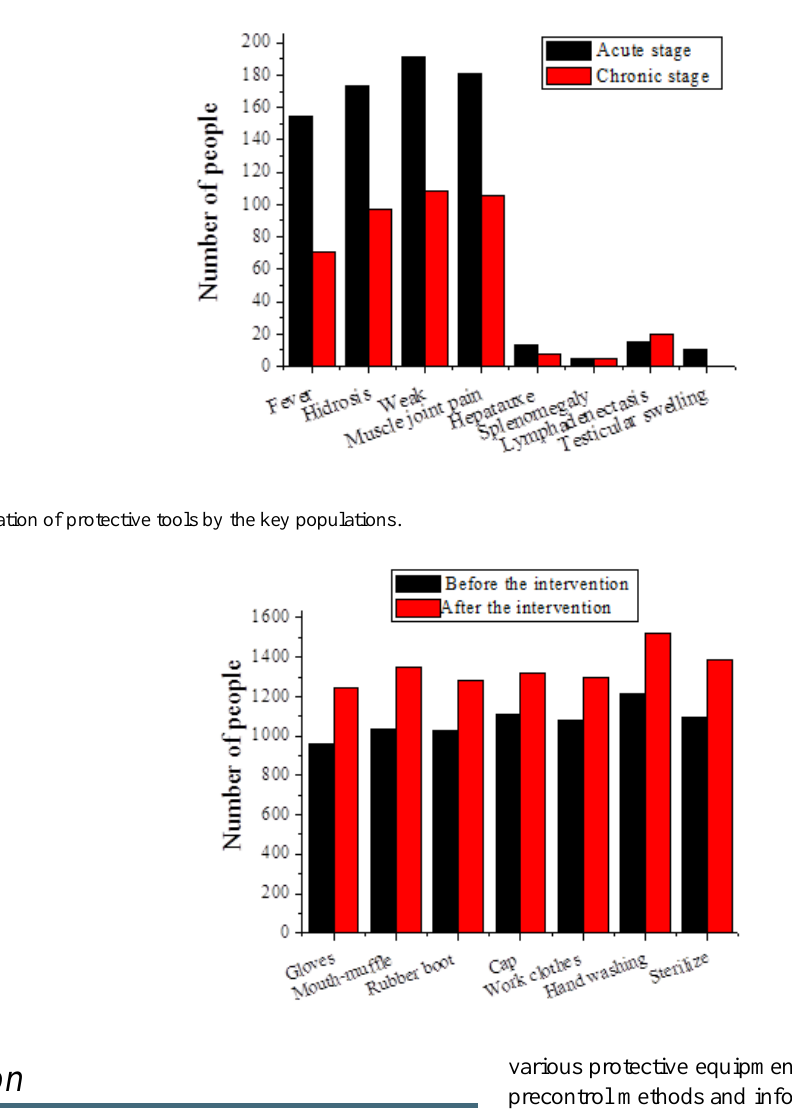
Figure 4. Clinical symptoms of patients at different stages.